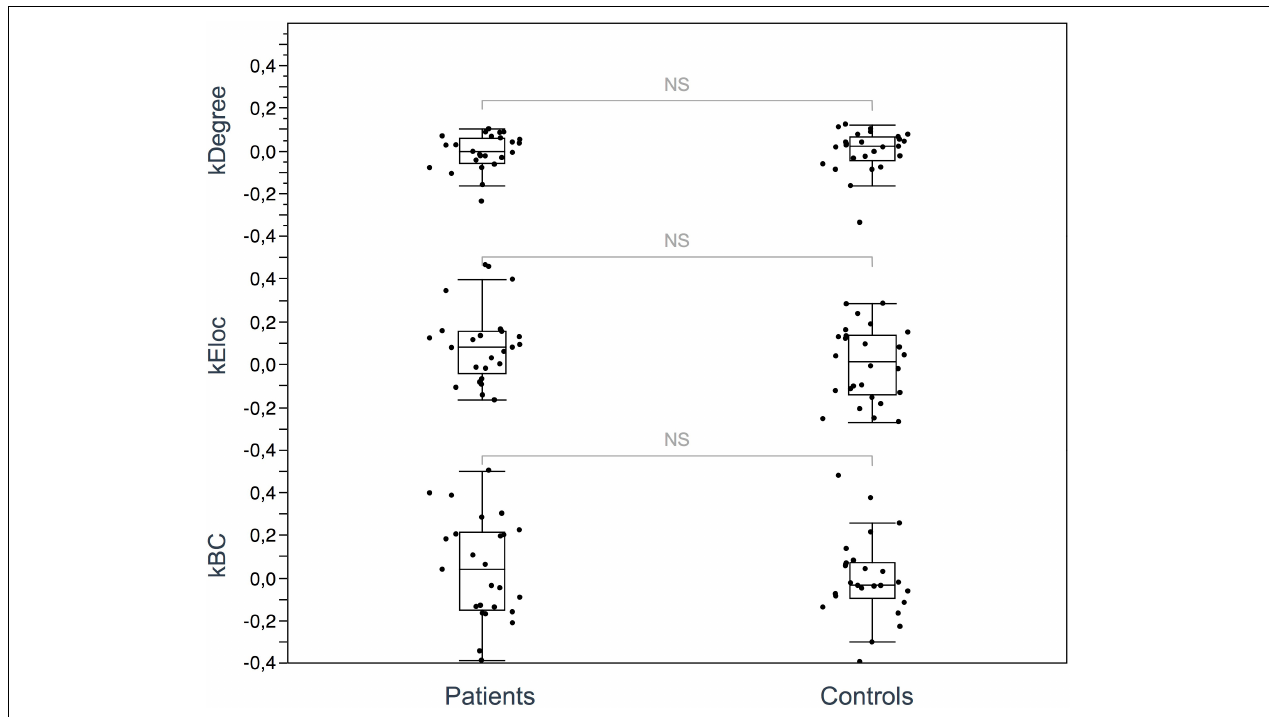
FIGURE 4 | Hub disruption index. The box plots show the κ index of each subject for 3 metrics: κ -degree, κ -Eloc, κ -BC. No significant differences were identified between ALS patients and controls. Differences were considered significant at p < 0.05 for each